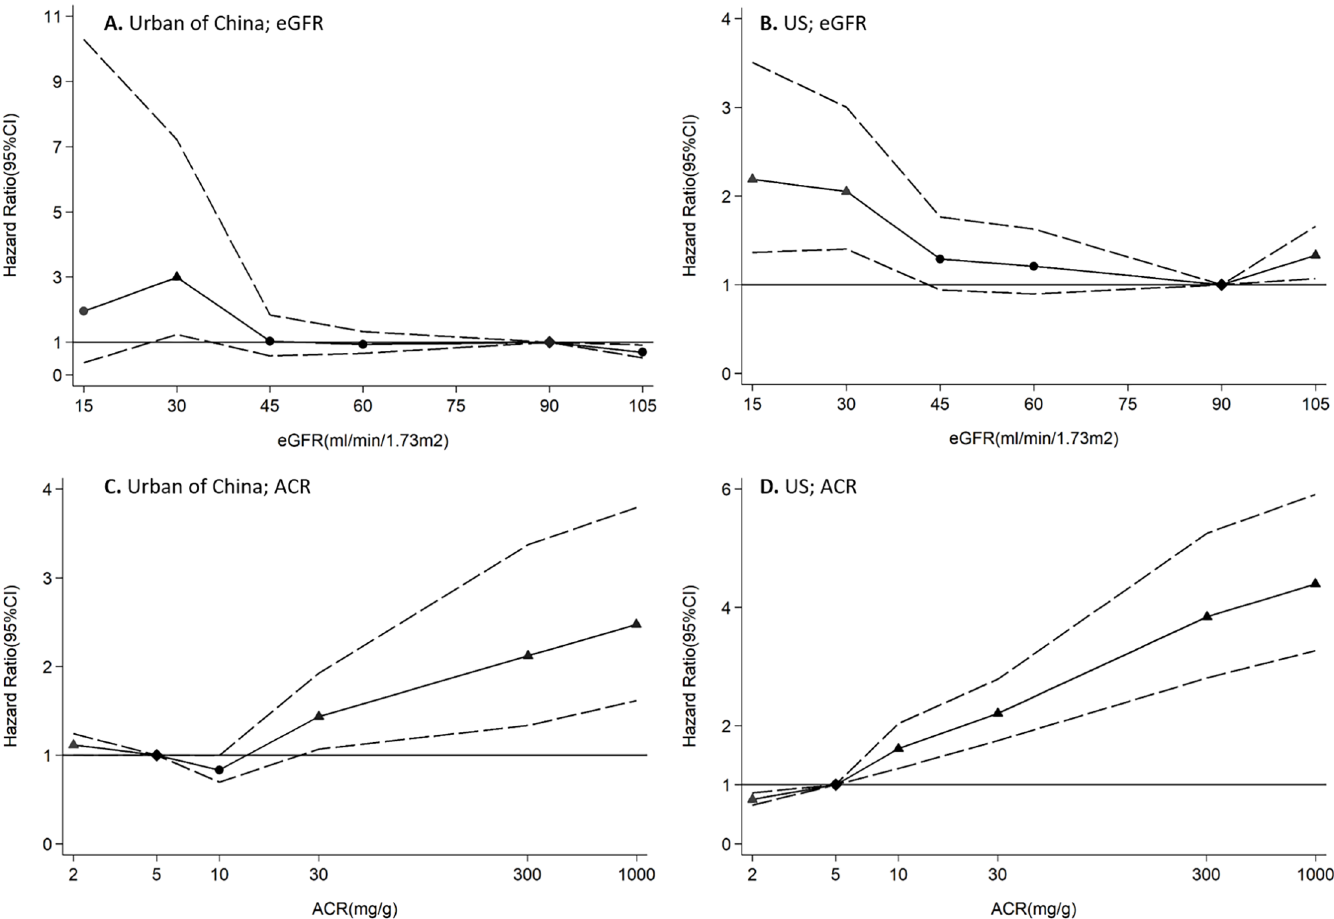
hypertension, diabetes, body mass index, and ln(ACR)(when testing for spline eGFR)/eGFR(when testing for spline ACR). The reference (diamond) was eGFR 90 mL/ min/1 (cid:1) 73 m 2 and ACR 5 mg/g, respectively. Triangles represent statistically significant and circles represent not significant. Abbreviation: HR = Hazard ratio, CI = Confidence interval, eGFR = Estimated glomerular filtration rate, ACR = Albumin-to-creatinine